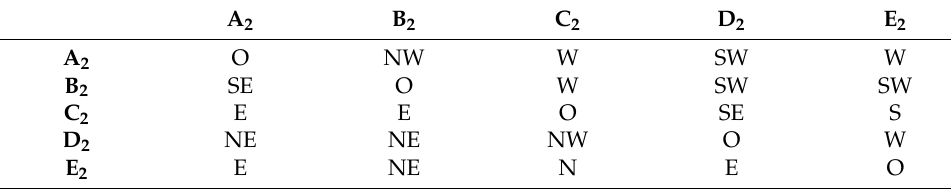
Table 15. Distance relations in the database scene (b) in Figure 17. A 2